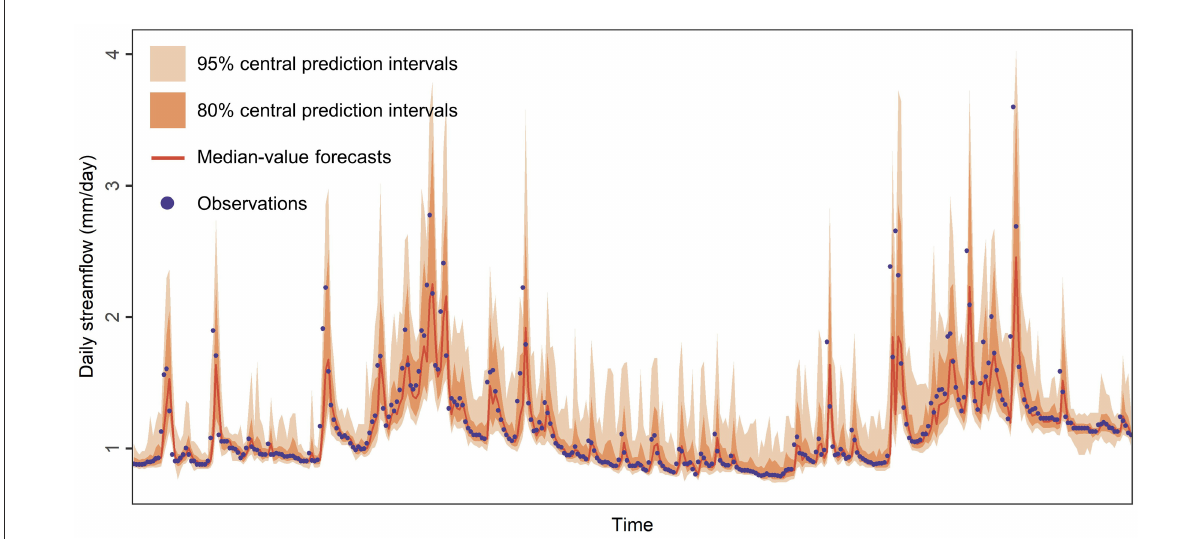
FIGURE1 Probabilistic one-day ahead forecasts that are consisted of (i) median-value forecasts (depicted with a red line), (ii) 80% central prediction intervals (depicted with a dark orange ribbon) and (iii) 95% central prediction intervals (depicted with a light orange ribbon) for a daily streamflow time series (depicted with purple